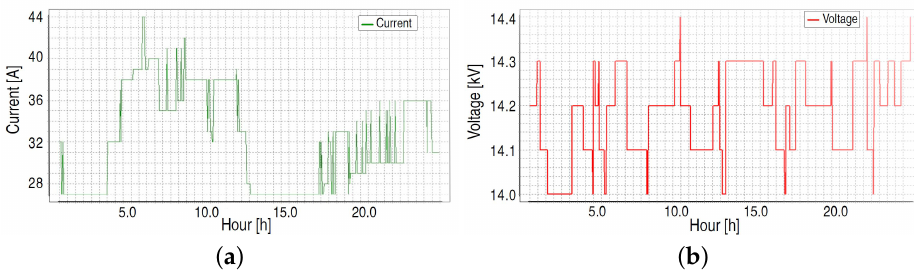
Figure 6. Data measured in the Sampling Campaign: ( a ) current behavior and ( b ) voltage behavior.